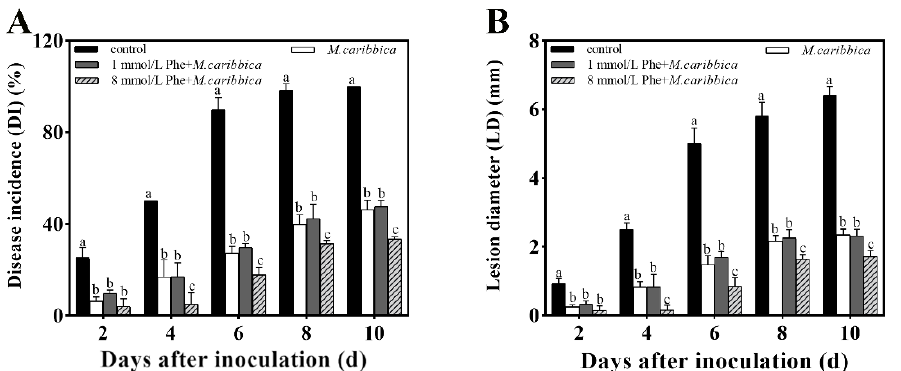
Figure 8. The effect of different concentrations of Phe on the biocontrol of jujube black spot rot by M. caribbica . The DI ( A ) and LD ( B ) were recorded for jujube black spot rot in fruit stored at 25 °C for 10 d. Error bars indicate the standard deviation, and different letters indicate significant differences ( p < 0.05).